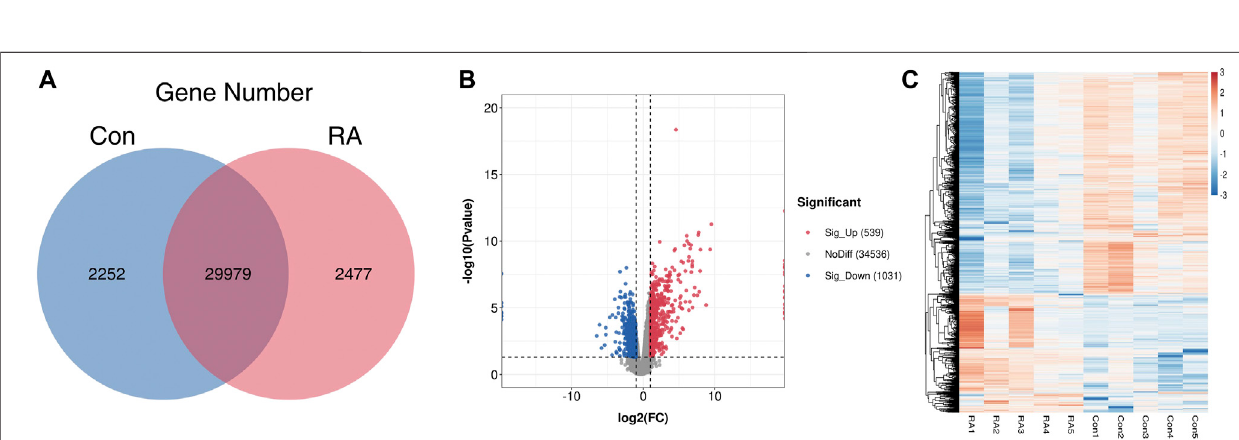
Frontiers in Pharmacology |